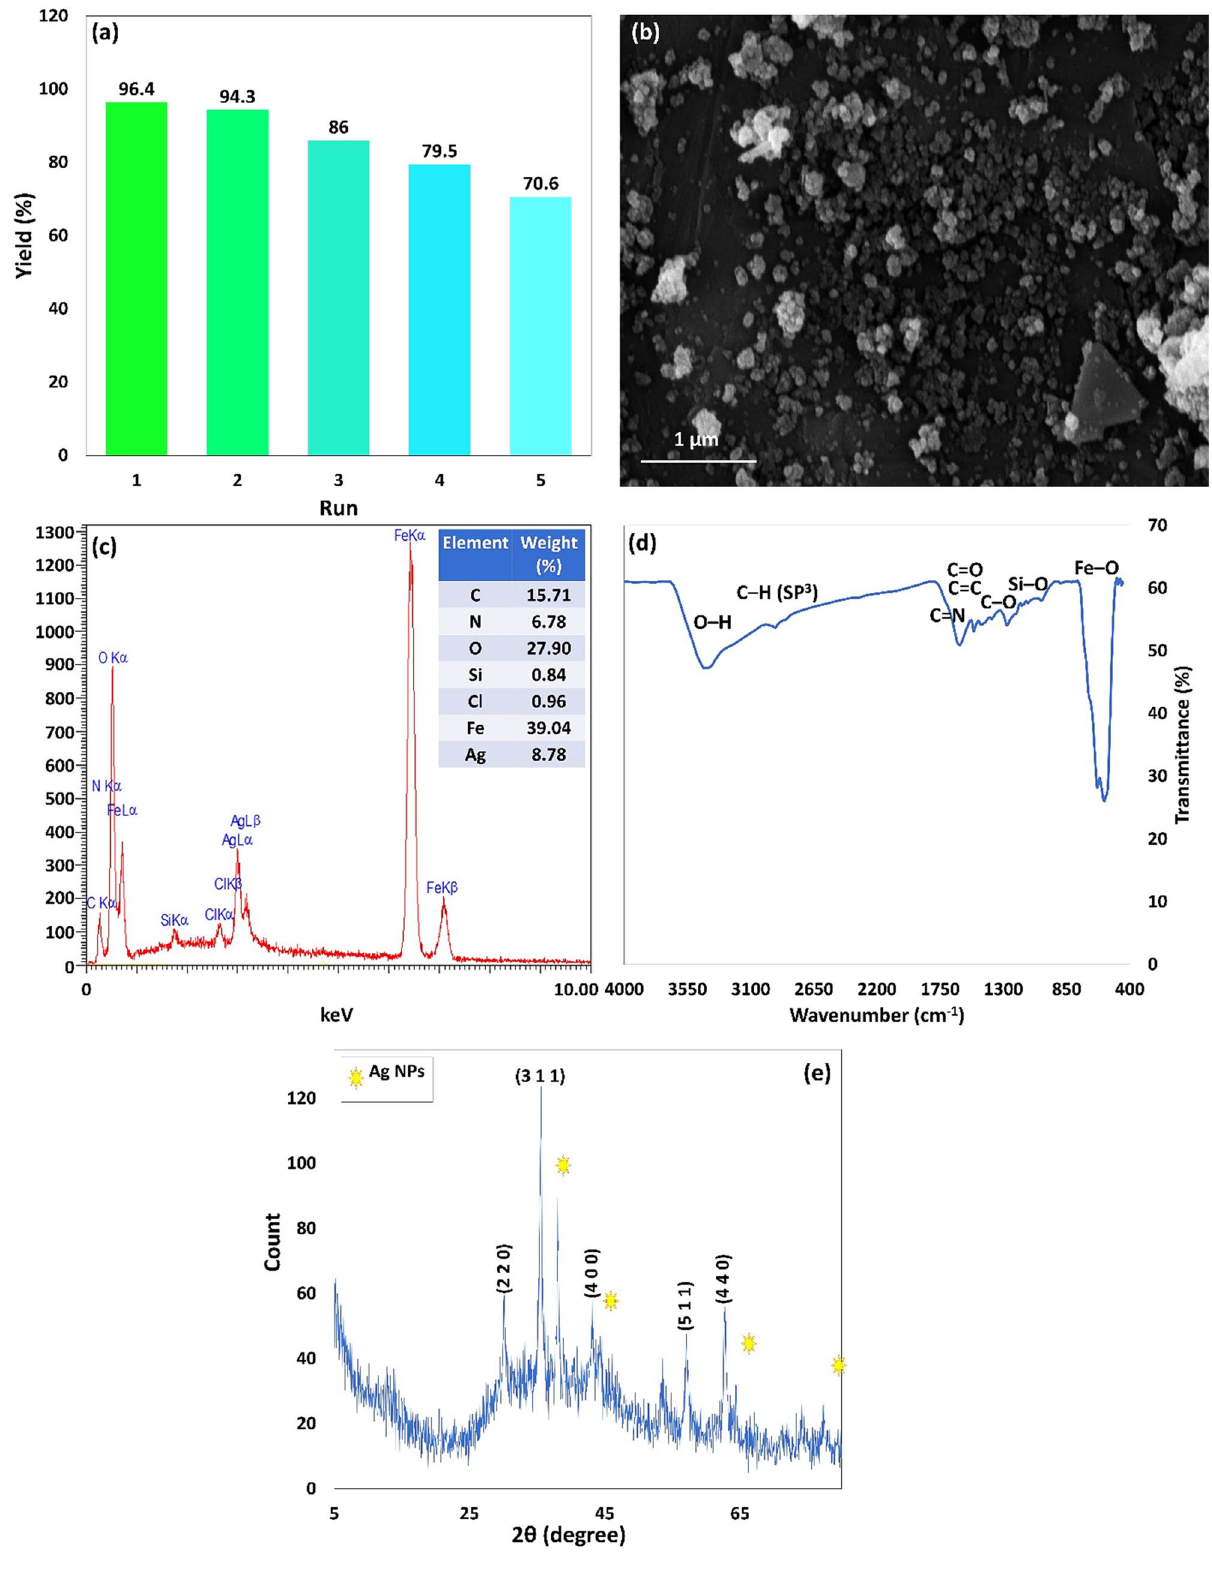
Figure 9. ( a ) The retrievability assessment and ( b ) SEM image, ( c ) EDX, ( d ) FTIR spectrum, and ( e ) XRD pattern of